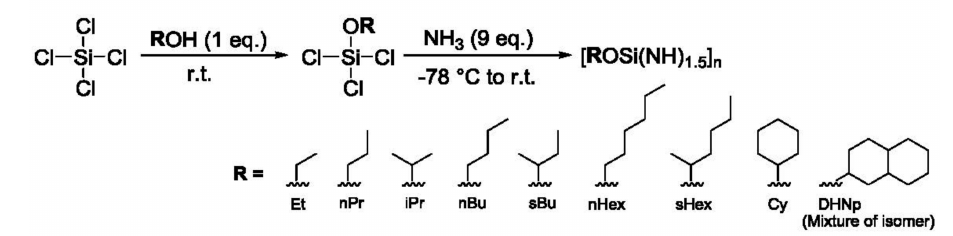
Figure 1. 29 Si–NMR spectrum of 800 ◦ C-pyrolyzed EtOSZ [24].